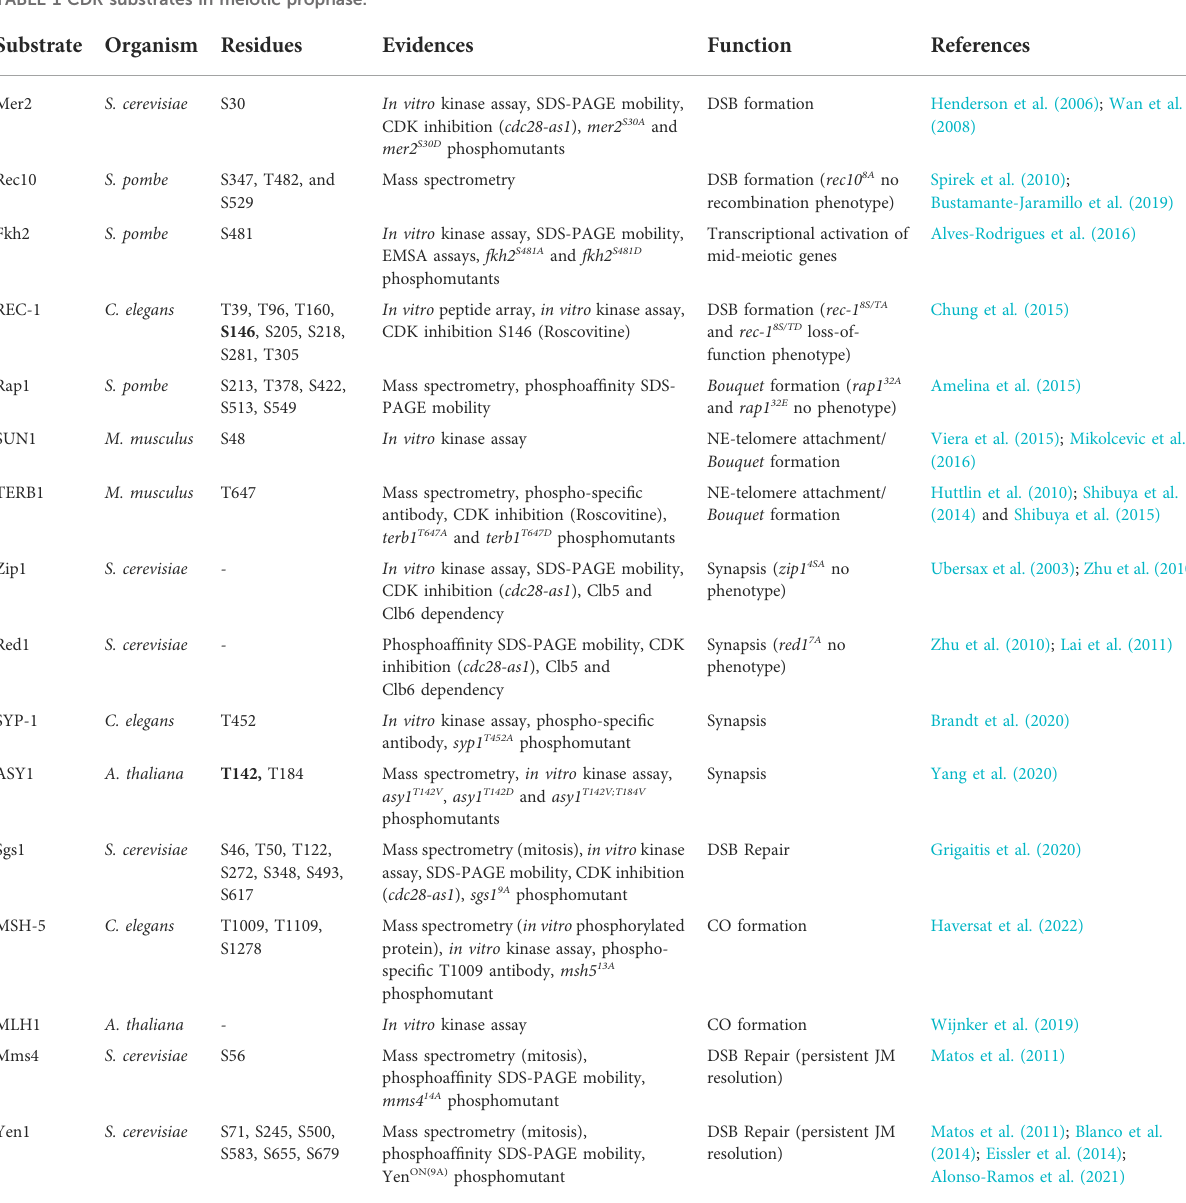
TABLE 1 CDK substrates in meiotic prophase. Substrate Organism